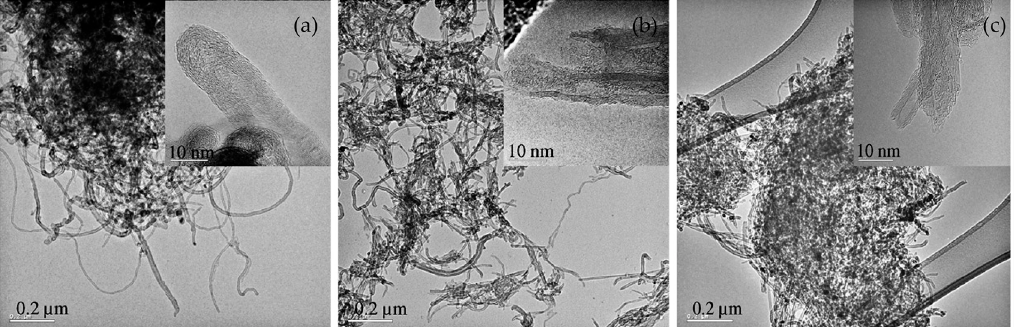
Figure 4. TEM (transmission electron microscopy) images of ( a ) as-synthesized CNTs, ( b ) CNTs ball milled with NH 4 HCO 3 as a functionalizing agent and process control agent (PCA), and ( c ) CNTs milled with no PCA. The presence of chemicals is shown to result in improved CNTs dispersion [81]. (Reproduced with permission from [81], Elsevier, 2008.)